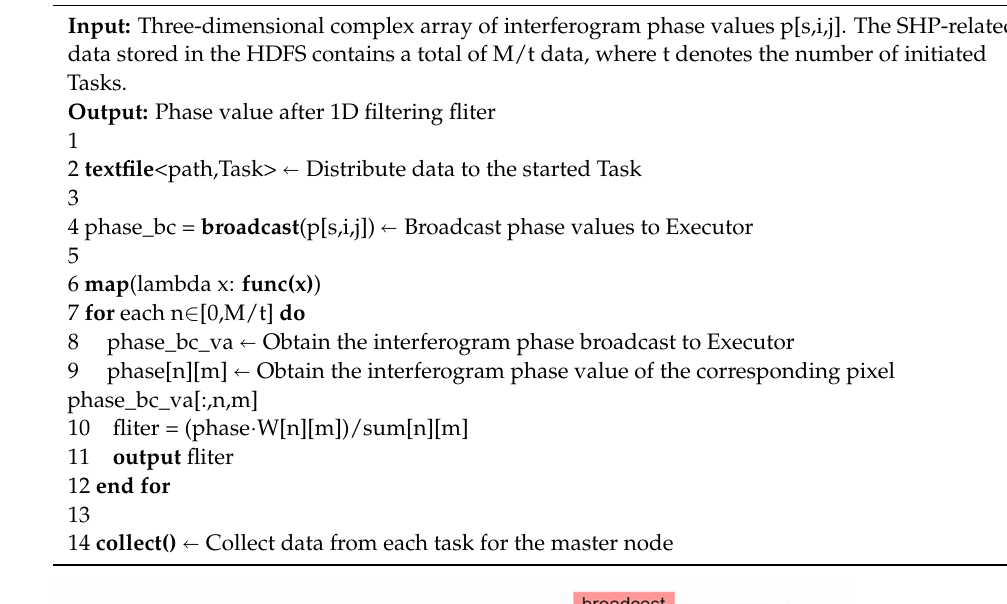
Algorithm 2. Parallel Spark-based Spatial Adaptive Filtering Algorithm